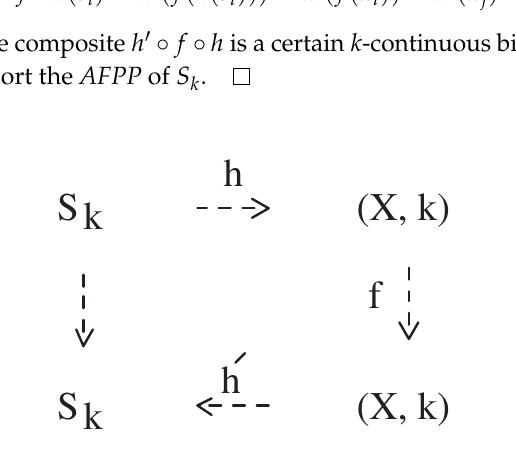
Figure 8. Explanation of the composite h (cid:48) ◦ f ◦ h